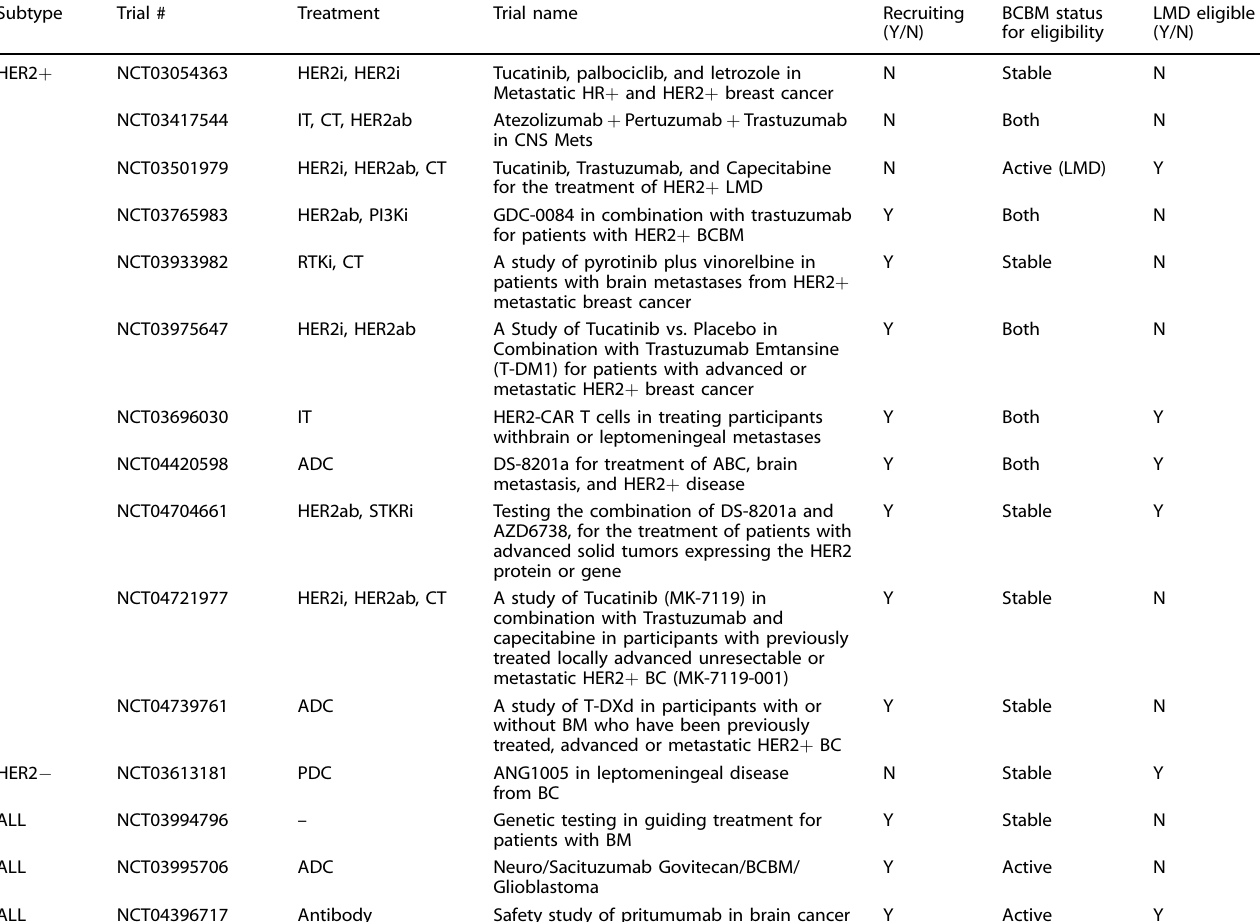
Table 4. A partial list of active clinical trials investigating therapeutic options for breast cancer patients with BCBM or